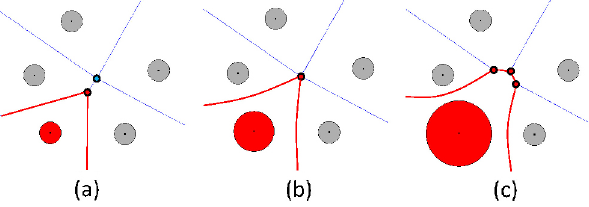
Fig. 15 A special case: a neighbor vertex in non-general position.